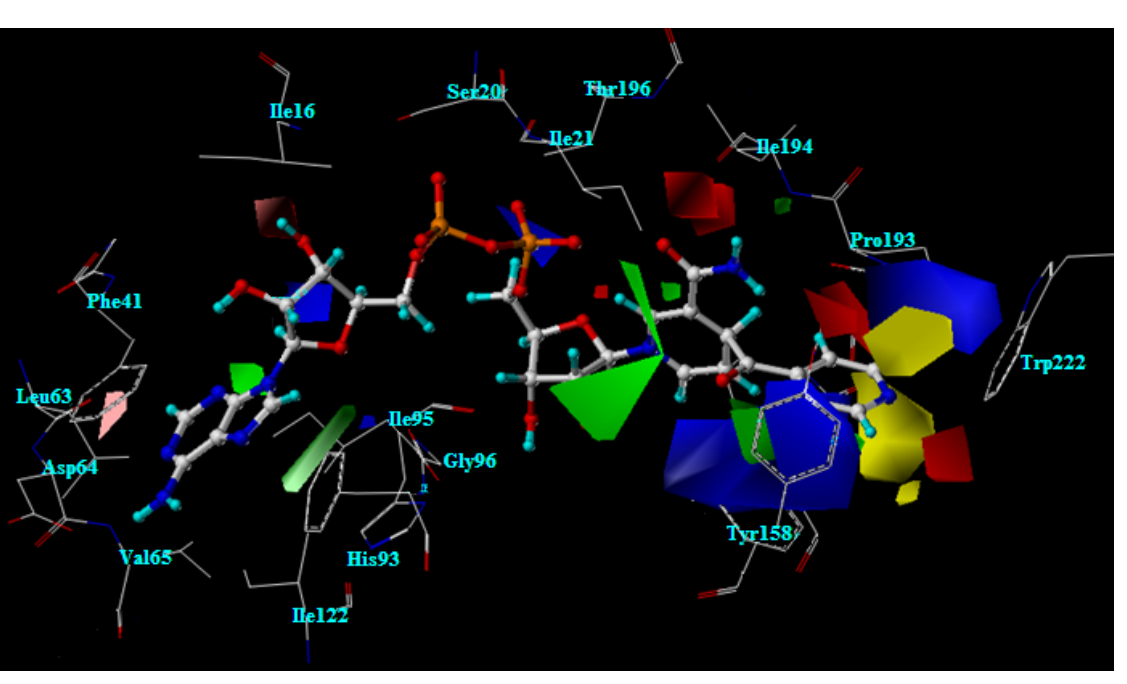
Figure 6. CoMFA contour maps for steric and electrostatic fields.